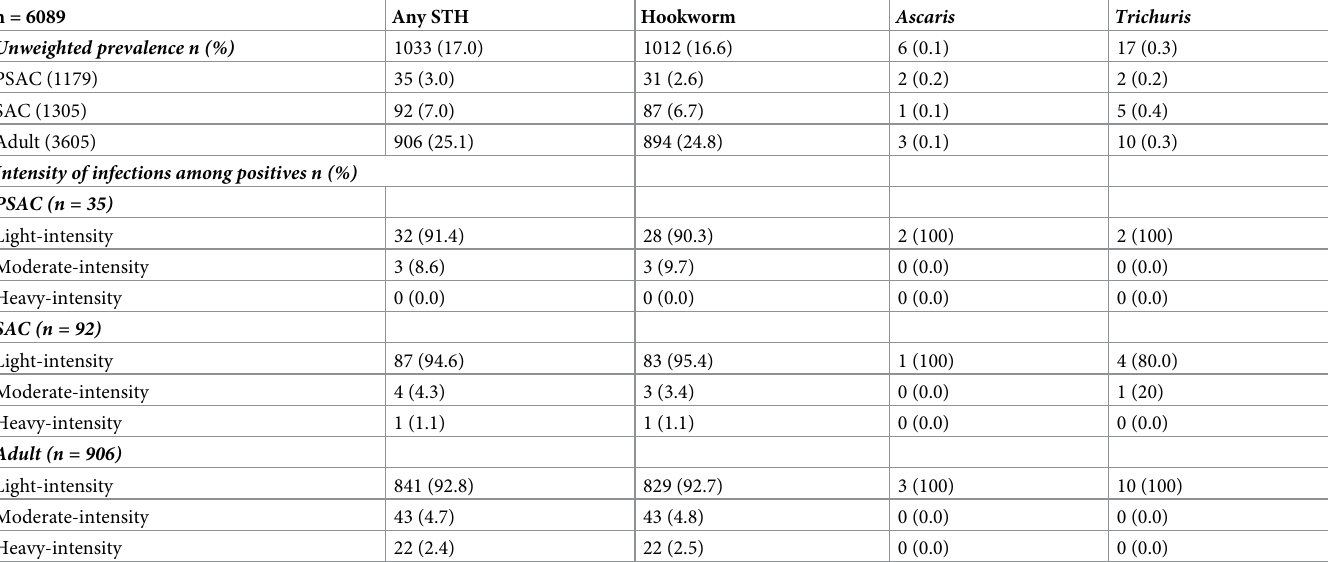
Table 1. Prevalence and intensity of soil transmitted helminths in the surveyed participants by age